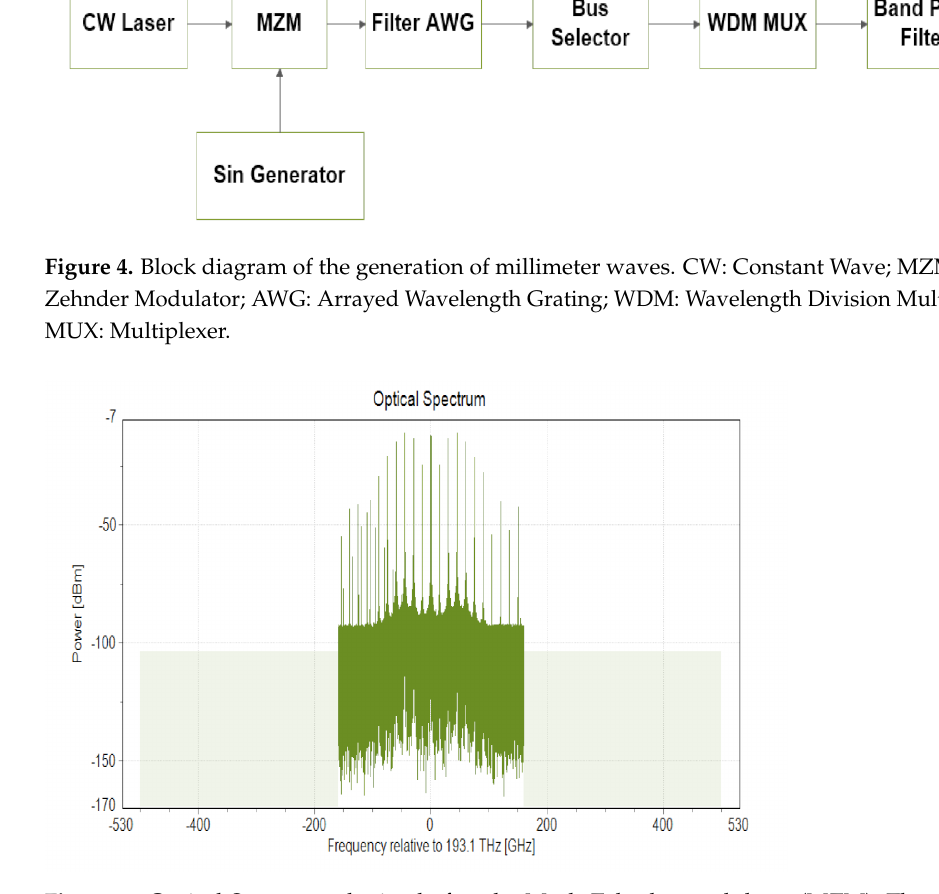
Figure 5. Optical Spectrum obtained after the Mach-Zehnder modulator (MZM). The spectrum consists of sidebands with frequency spacing equal to 15